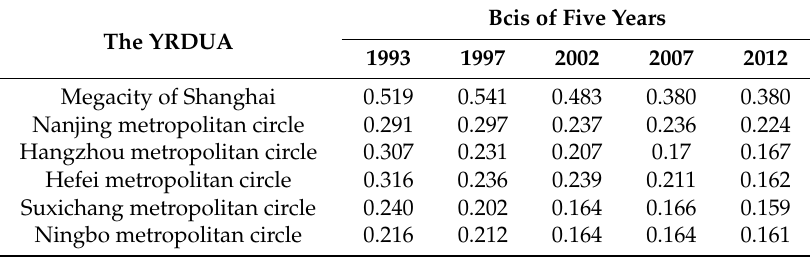
Table 2. Buffer compactness indexes (BCIs) of the core megacity of Shanghai and five metropolitan circles for